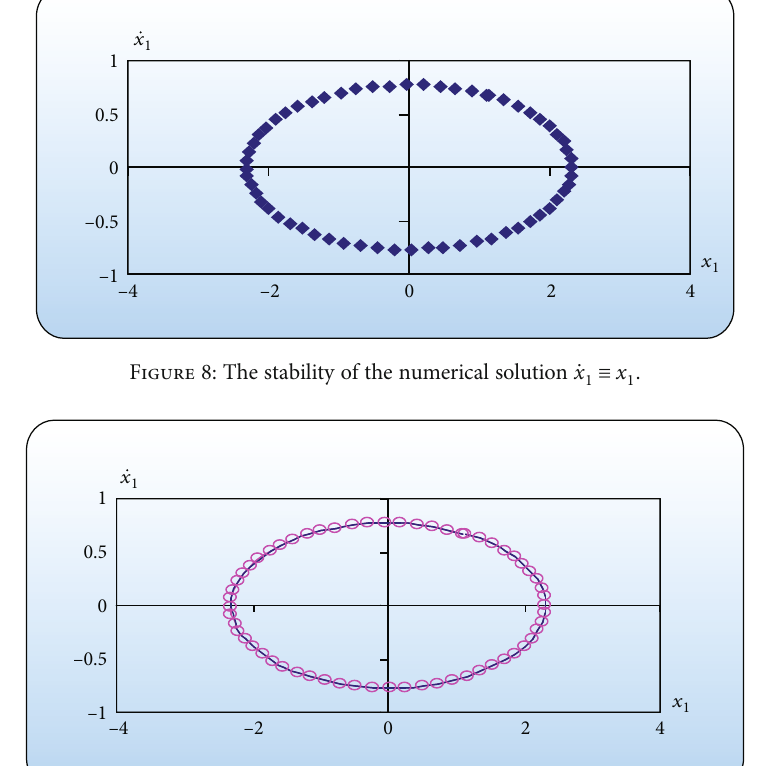
Figure 7: The stability of the analytical solution _ x